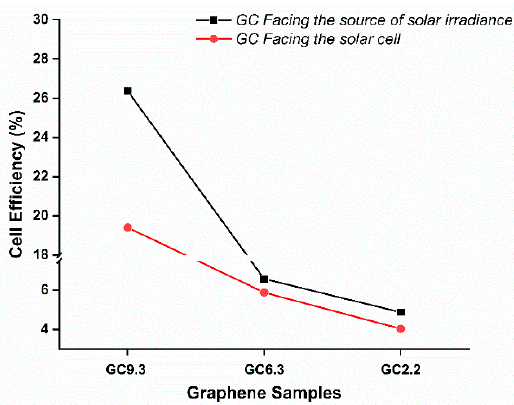
Figure 6. The cell efficiency of single-junction (polycrystalline Si) solar cell for the GC facing the source of solar irradiance and GC 9.3 facing the solar cell.